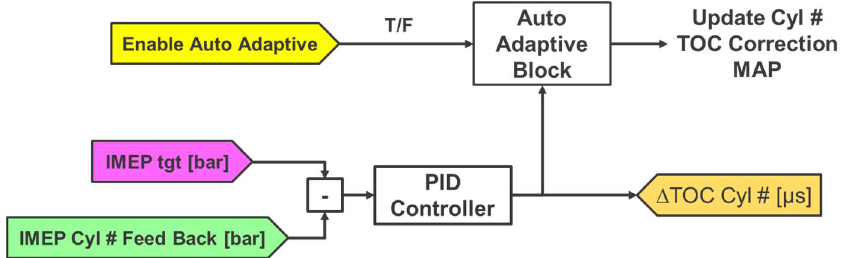
Figure 4. Block scheme of the closed loop part of the controller defining the correction component of the feed-forward TOC.